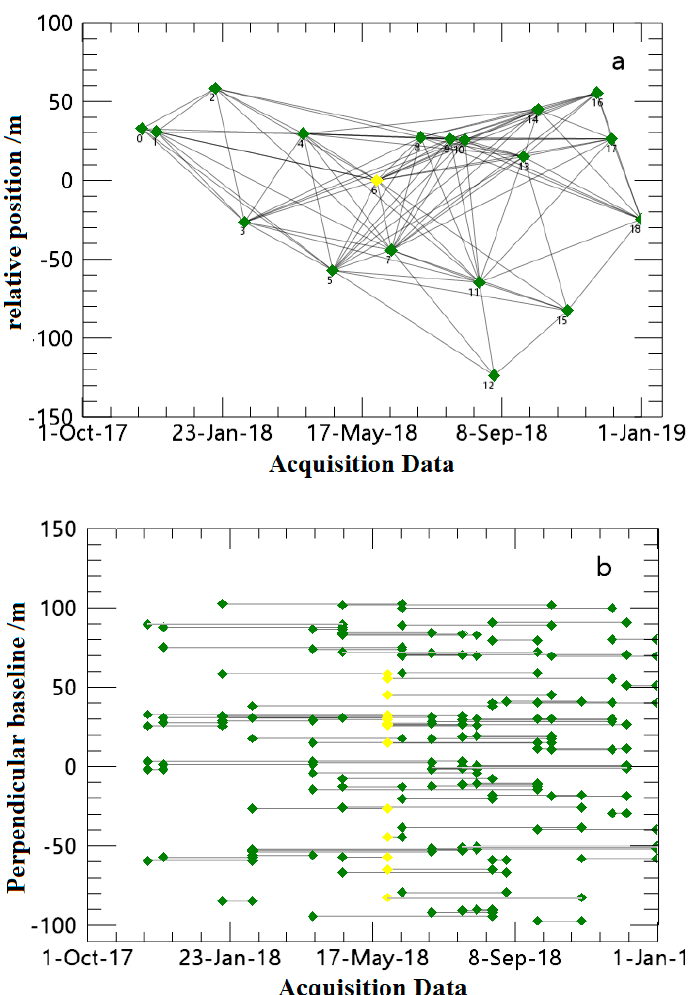
Figure 3. Spatial and temporal baselines of the Sentinel-1A data used in this study. ( a ) Spatial–baseline plot, the distance between two points represents the size of spatial baseline. ( b ) Time–baseline plot. The image pairs are connected by lines, the images are represented by green circles, and the super main images are represented by yellow circles; the distance between two points represents the size of time baseline.